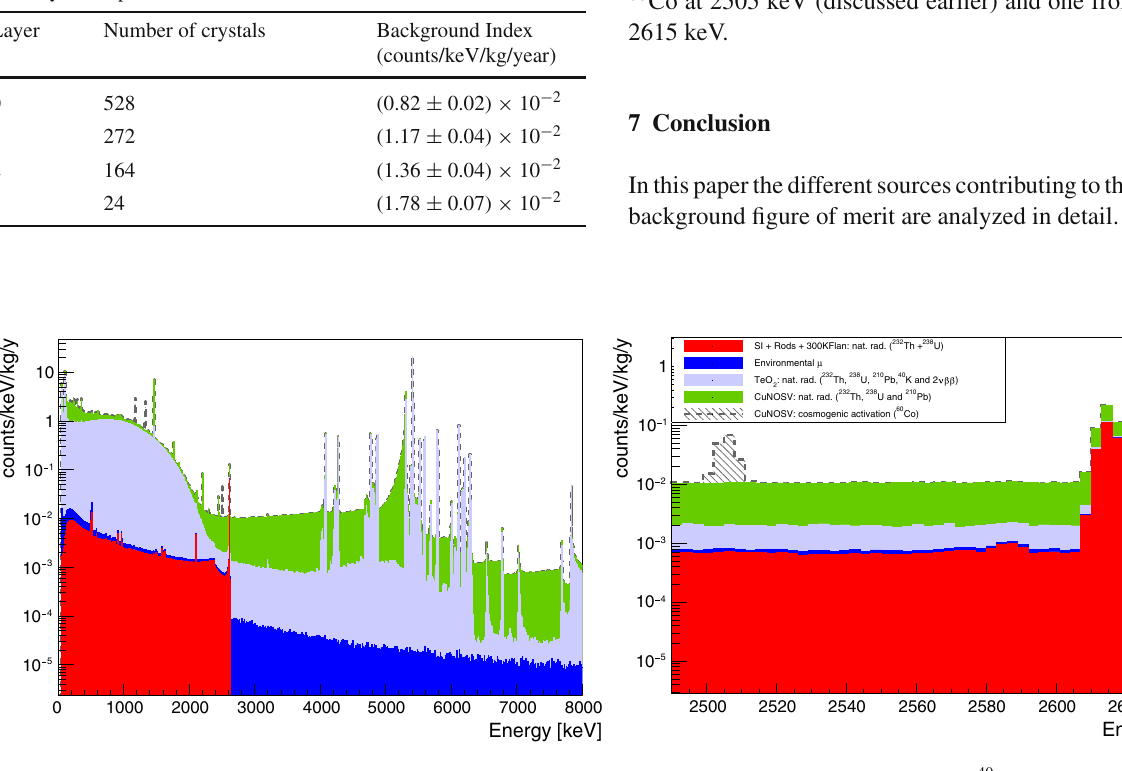
Fig. 7 Anticoincidence spectrum resulting from the sources analyzed in this paper (histograms corresponding to the different sources are stacked one over the other, the dotted contour shows the total predicted spectrum). Only sources with activities incompatible with zero are con- sidered, with the exception of the 60 Co contamination in CuNOSV (reported at its 90% C.L. upper limit). Due to their expected large con-